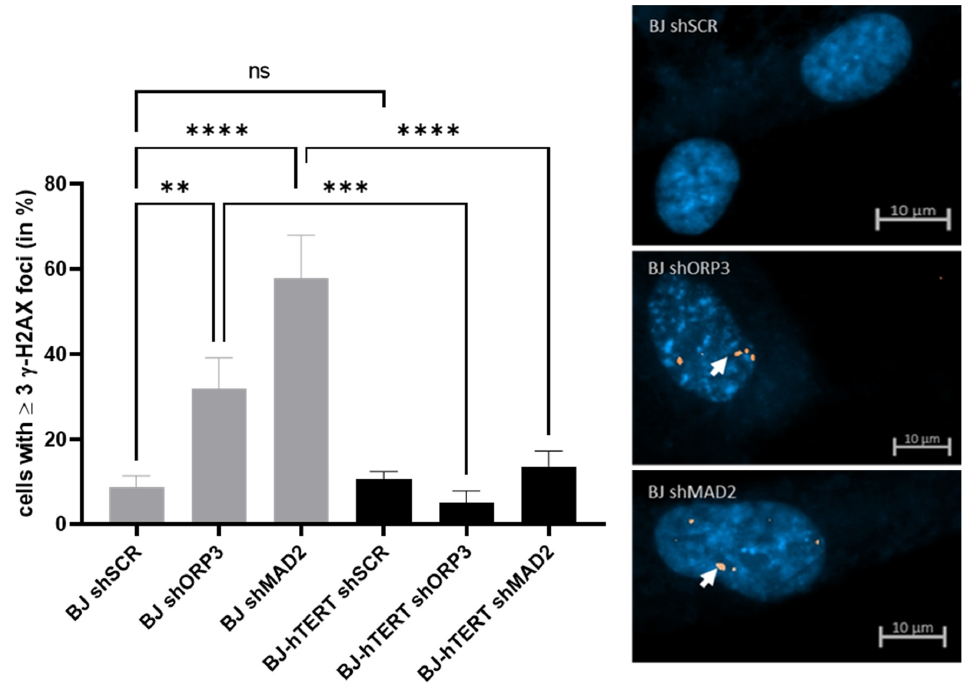
Figure 5. Evaluation of γ -H2AX foci formation upon aneuploidy-induced replication stress. ( Left ) The bar plot displays the impact of ORP3 or MAD2 downregulation on γ -H2AX foci formation in BJ and BJ-hTERT cells. pGIPZ-shSCR was used as an shRNA control vector. One-way ANOVA test was applied, followed by a Fisher’s LSD post hoc test, with a confidence interval of 95%. ( Right ) Representative images from BJ-shSCR (top), BJ-shORP3 (middle), and BJ-shMAD2 (bottom) cells. A total of 210 cells were counted from n = 6 independent experiments. The representative pictures show DAPI-stained nuclei with nuclear pRPA2 foci (white arrow). ns ( p > 0.05), ** ( p ≤ 0.01), *** ( p ≤ 0.001), **** ( p ≤ 0.0001).